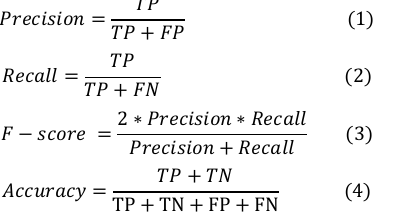
15.92° outlier cut-off (Figure